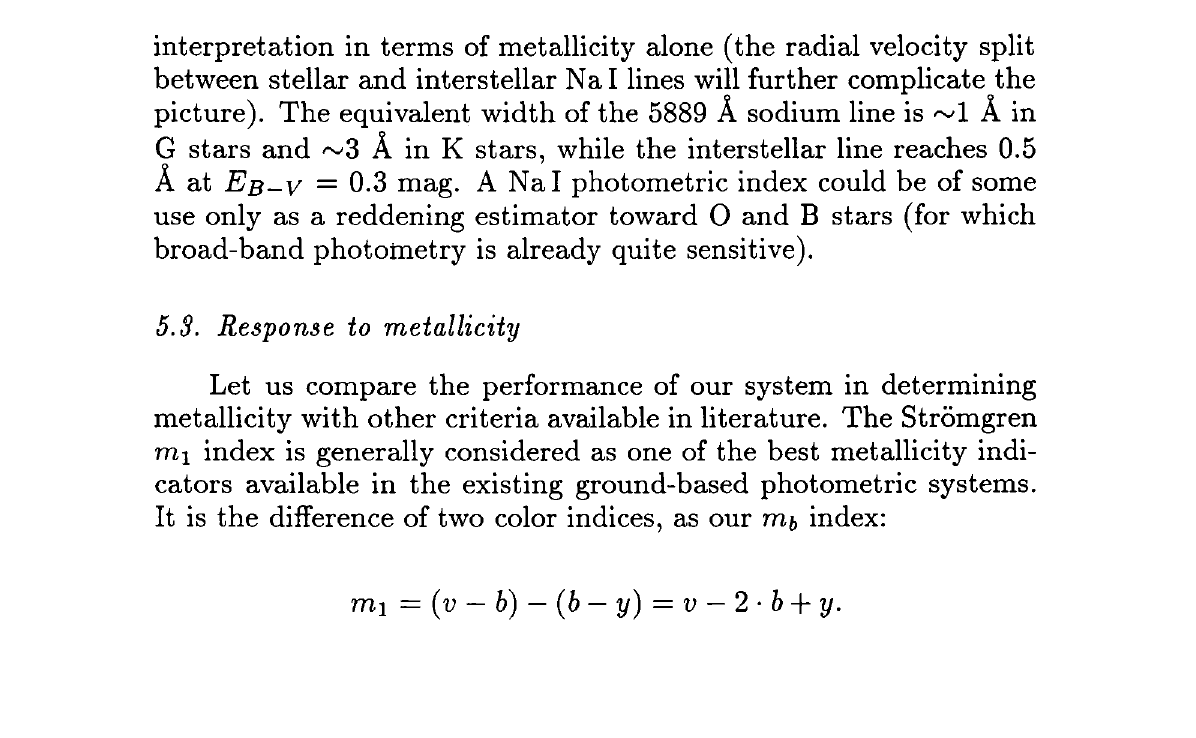
Fig. 7. Comparison between metallicity indices in our system and the Strömgren photometric system for solar-type stars. The curves are the loci of constant temperature and metallicity but different gravities within the 0.0 < log g < 4.5